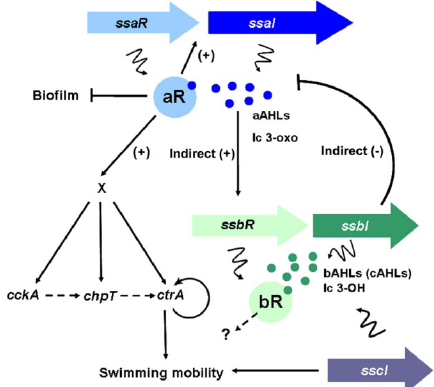
Figure 2. Interconnected QS network and model for ssaRI and cckA-chpT-ctrA regulatory circuit that controls KLH11 flagellar motility. Lengths of the ssaRI , ssbR , and sscI genes are drawn in scale. Genes and products are colored in corresponding colors, with R-genes more darkly colored and I-genes lighter colored. The dark blue dots represent the AHLs, mainly long chain (lc) 3-oxo-HSLs, synthesized by SsaI. The dark green dots represent the AHLs, mainly long chain (lc) 3-OH-HSLs, synthesized by SsbI. Lines with bars indicate inhibition and arrows indicate activation. Squiggly lines indicate translation of genes or products of enzyme action. The dashed line with arrows indicates the potential phosphate flow from CckA to CtrA via ChpT. The curved lines with arrows around CtrA indicate positive feedback loops. The “X” indicates the unknown regulator(s). The figure is modified from references [17] and